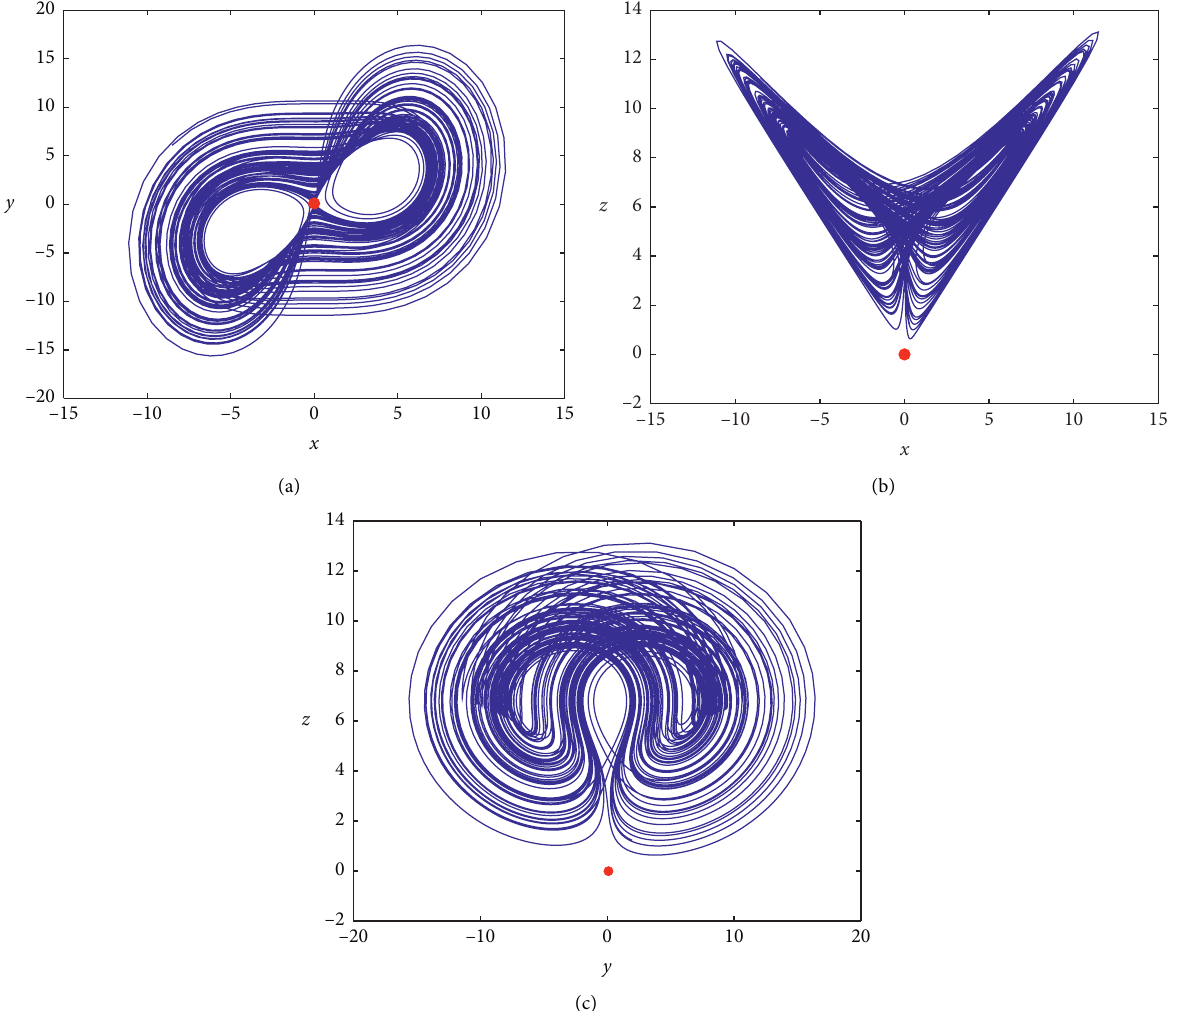
Figure 1: Phase diagrams in different projections of chaotic systems (2) from initial values (1, 2, 3), red, and (1, 2, − 1). (a) Phase portraits in the x - y plane. (b) Phase portraits in the x - z plane. (c) Phase portraits in the y - z